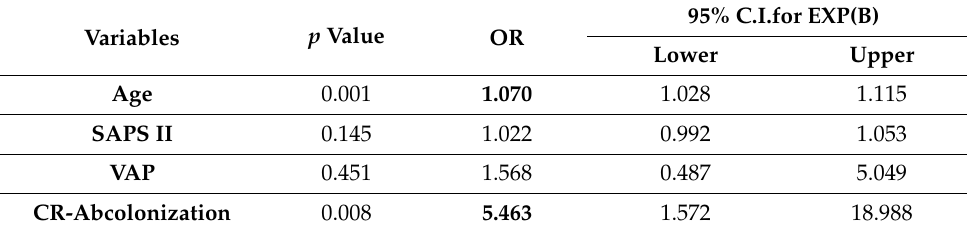
Table 2. Multivariate analysis for